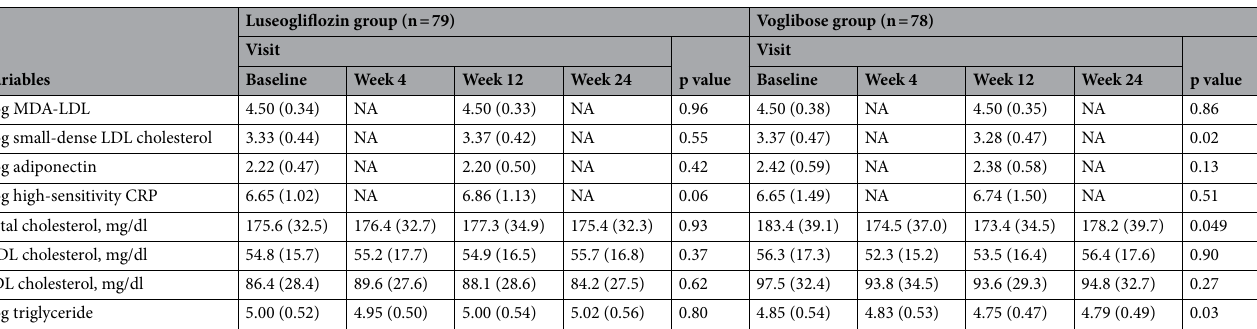
Table 3. Time-dependent changes in biomarker levels. Data are presented as the mean (standard deviation). Log-transformed values of MDA-LDL, small-dense LDL cholesterol, adiponectin, high-sensitivity CRP, and triglyceride concentrations are shown. CRP C-reactive protein, HDL high-density lipoprotein, MDA-LDL malondialdehyde low-density lipoprotein.